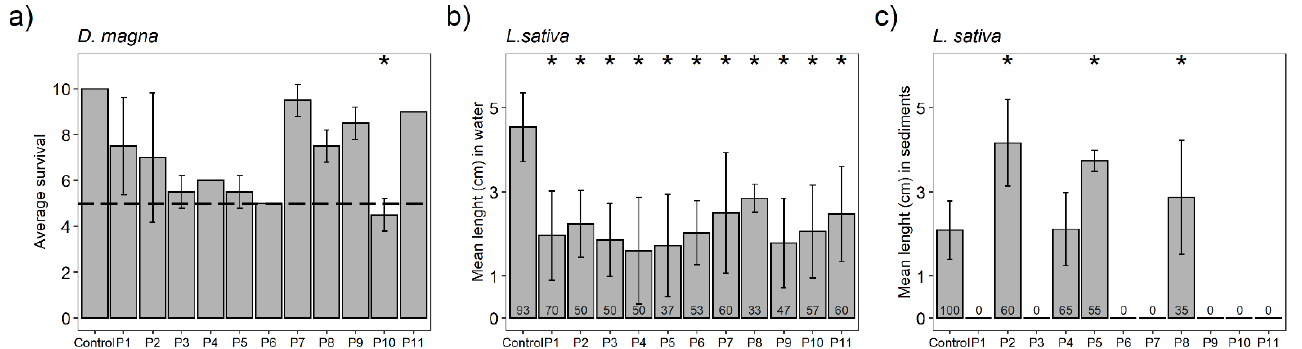
Figure 4. Results of the bioassays performed with neonates of Daphnia magna ( a ) and seeds of Lactuca sativa ( b , c ) with water and sediment samples. For the Daphnia magna tests, data show the average number of surviving neonates (48 h) ± standard deviation, and the asterisk (*) represents significant differences ( p ≤ 0.05) with respect to control. The dashed black line indicates a 50% reduction in survival. For the L. sativa tests, data represent the average length ± standard deviation. (*) represents significant differences ( p ≤ 0.05) with respect to the control, and the numbers within the bars show the germination percentages ( n = 15).